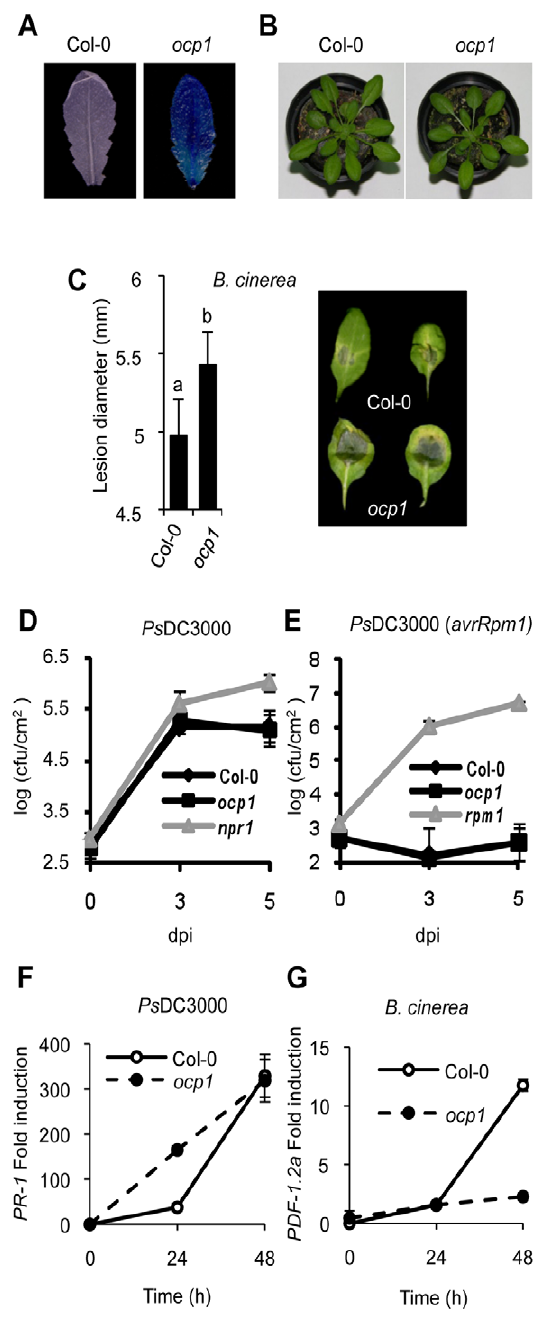
Figure 1. Characterization of ocp1 plants. (A) Comparative histochemical analysis of GUS activity in rosette leaves from a parental wild-type plant carrying the P Ep5C :GUS transgene (left), and ocp1 mutant plant (right). (B) Macroscopic comparison of 3-week-old wild-type (left) and ocp1 plants (right). (C) Resistance response of wild-type and ocp1 plants to virulent B. cinerea . Lesion size was measured 5 days after inoculation (dpi). Data points represent average lesion size 6 SE (n $ 30 lesions). Representative leaves from wild-type and ocp1 plants 4 dpi. (D–E) Growth rates of virulent Ps DC3000 (D) and avirulent Ps DC3000 ( AvrRpm1 ) (E) in Col-0, ocp1 and npr1 or rpm1 plants. (F–G) RT-qPCR expression analysis of PR-1 (F) and PDF1.2a (G) in wild-type and ocp1 plants at different times following inoculation with Ps DC3000 (F) and B. cinerea (G). Data represent the mean 6 SD; n=3 biological replicates.